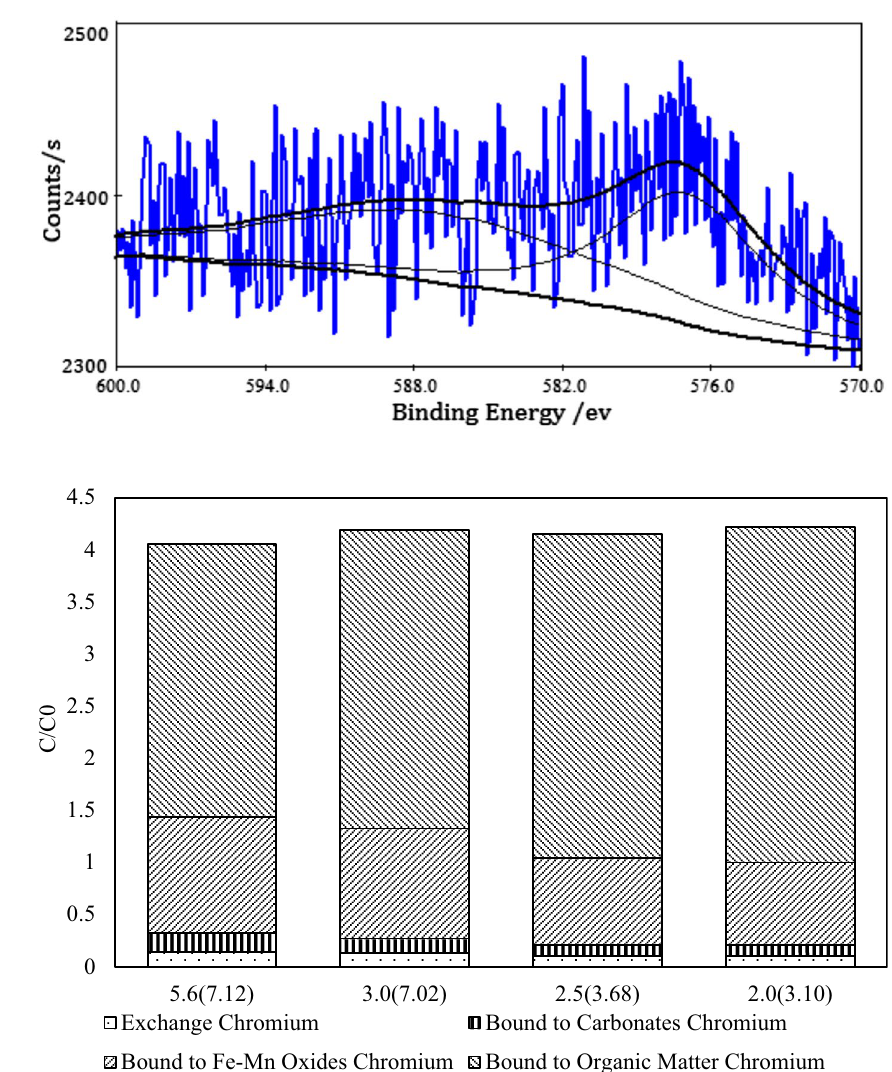
Fig. 2 Spectra of XPS for Cr(2 p 3/2 ) and Cr(2 p 1/2 ) on medium surface